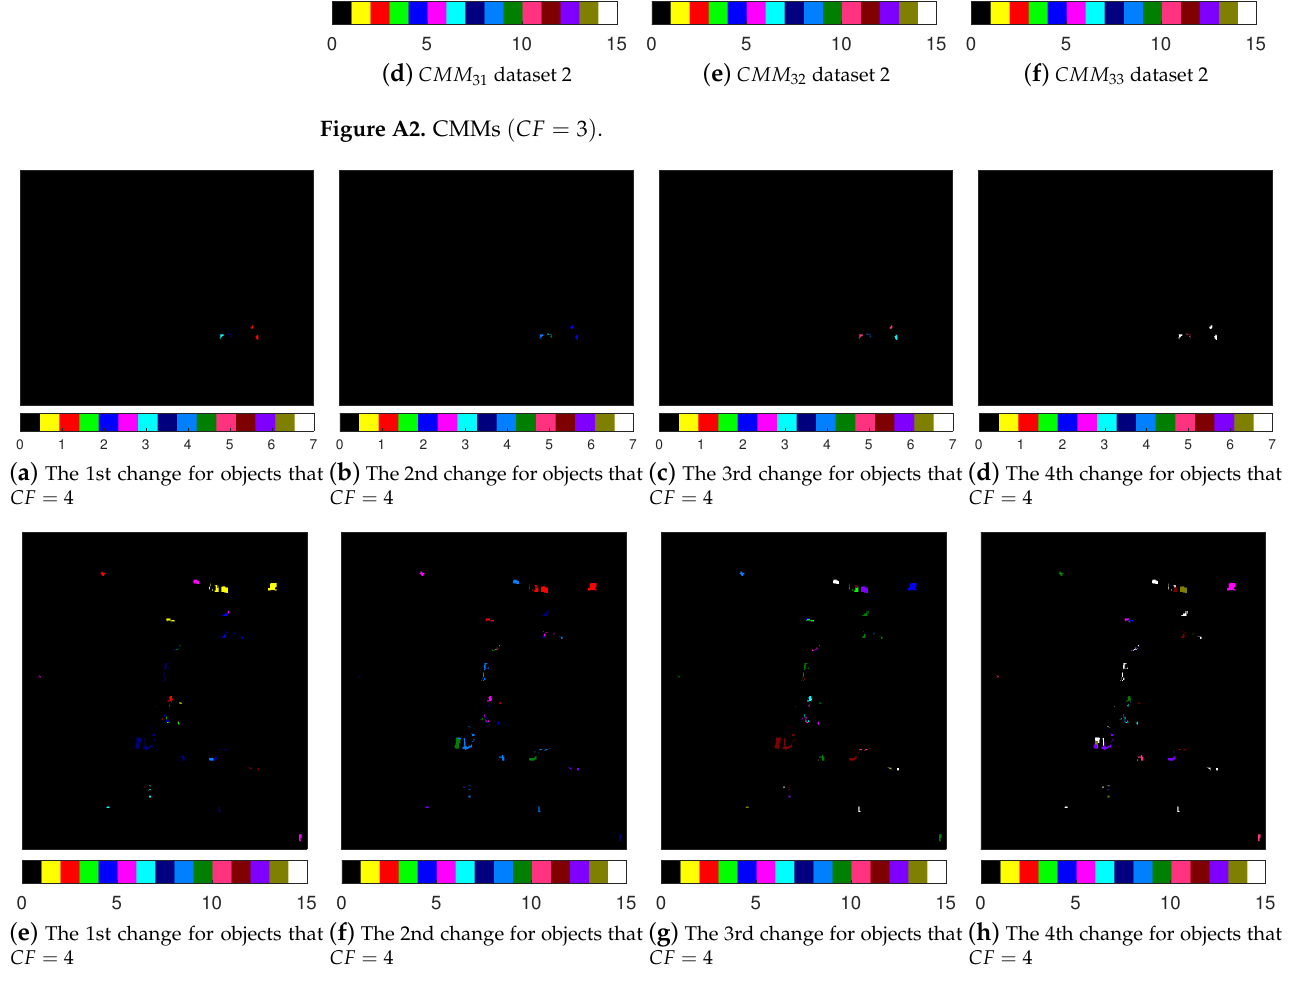
Figure A2. CMMs ( CF = 3 ) .